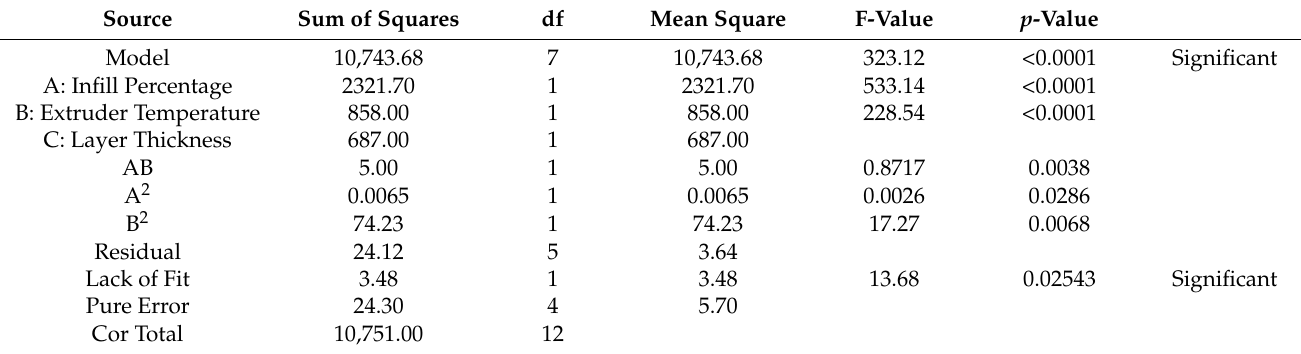
Table 4. Analysis of variance (ANOVA) model of top edge value.